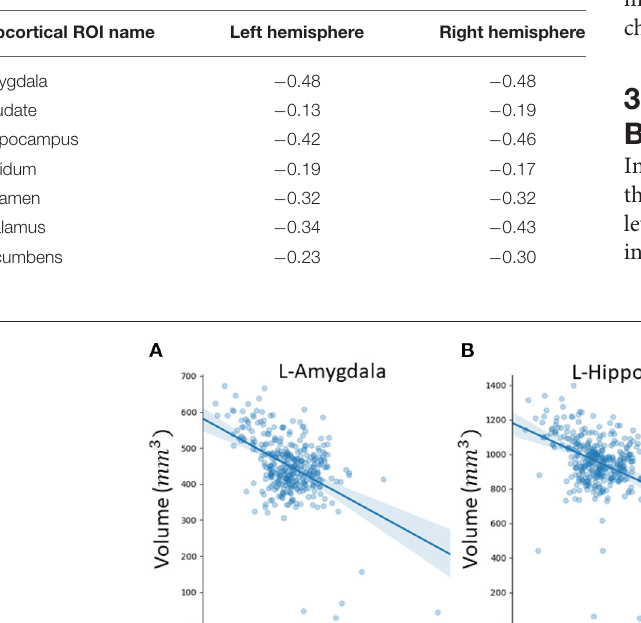
Frontiers in Aging Neuroscience |